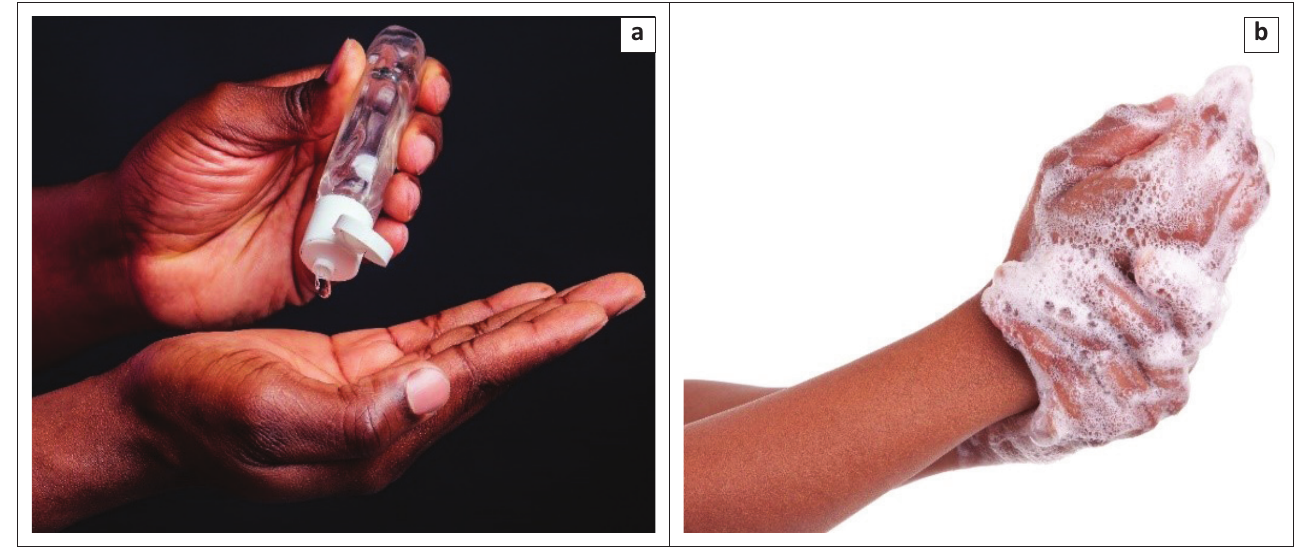
FIGURE 1: The regular use of sanitizers and frequent hand washing